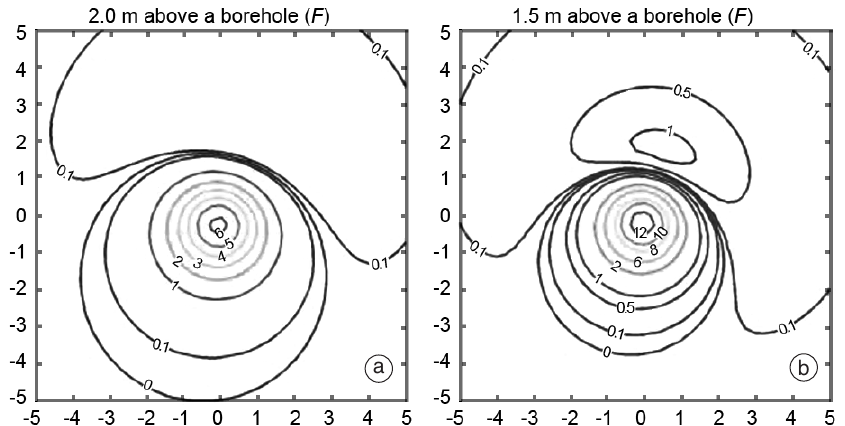
Fig. 6a,b. Changes in the total intensity above a borehole: a) 2.0 m above and b) 1.5 m above the ground sur- face. Unit in nT.